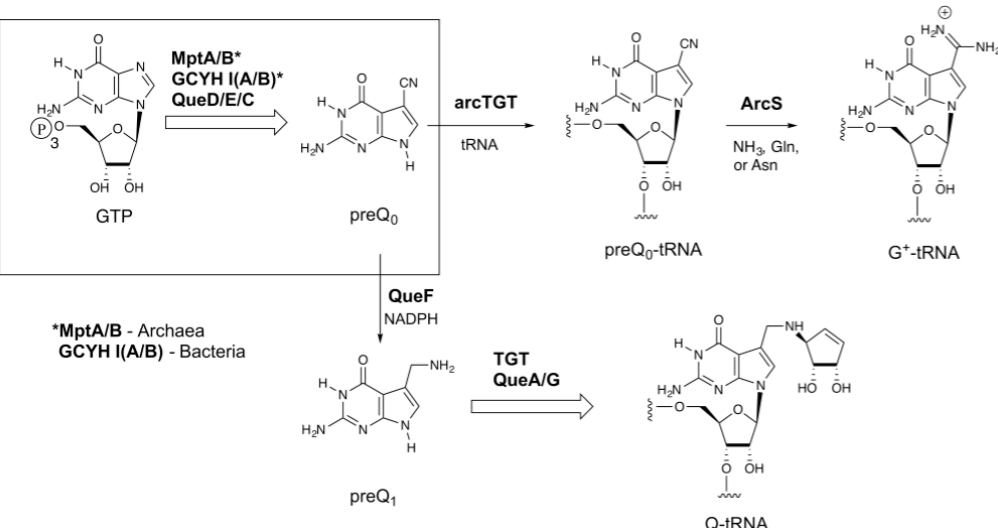
Figure 1. The biosynthetic pathways to 7-deazaquanosine modified nucleosides of transfer RNA (tRNA). The upper branch occurs in the Archaea and leads to archaeosine (G + ), while the lower branch occurs in bacteria and leads to queuosine (Q); the boxed region is common to both. *MptA/B catalyze the initial steps in Archaea [21,22], while GCYH IA or IB catalyze the initial step in bacteria [23,24]. ArcS: Archaeosine Synthase; preQ 0 : 7-cyano-7-deazaguanine; preQ 1 :